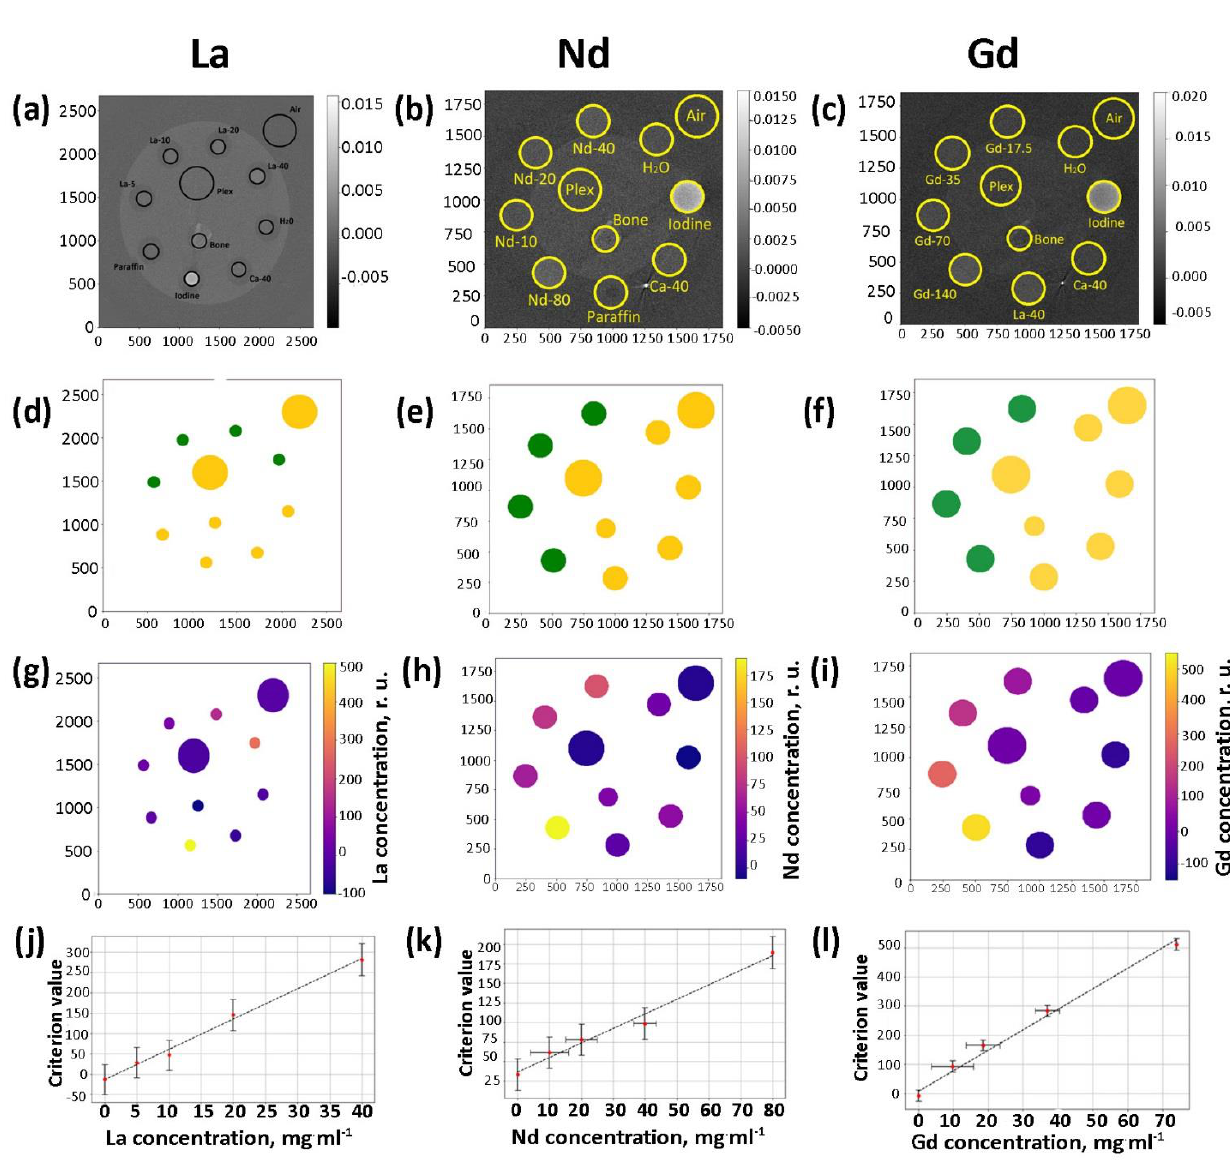
Figure 9. Upper row: CT images of phantom with the standard samples (water, iodine, paraffin, bone, and plex) and the investigated water solutions of La(NO 3 ) 3 ·6H 2 O ( a ), Nd(NO 3 ) 3 ·6H 2 O ( b ), and Gd(NO 3 ) 3 ·6H 2 O ( c ). The numbers shown in the images reflect the concentration of the contrasting element in the study solution. Second row: results of application of the photon energy criteria. Green corresponds to La ( d ), Nd ( e ), and Gd ( f ), while yellow corresponds to samples with no contrasting elements detected by criteria. Third row: the estimation of molar concentrations of La ( g ), Nd ( h ), and Gd ( i ). Bottom row: dependence of simulated concentration criteria from experimental concentrations of water solutions of La(NO 3 ) 3 ·6H 2 O ( j ), Nd(NO 3 ) 3 ·6H 2 O ( k ), and Gd(NO 3 ) 3 ·6H 2 O ( l ).